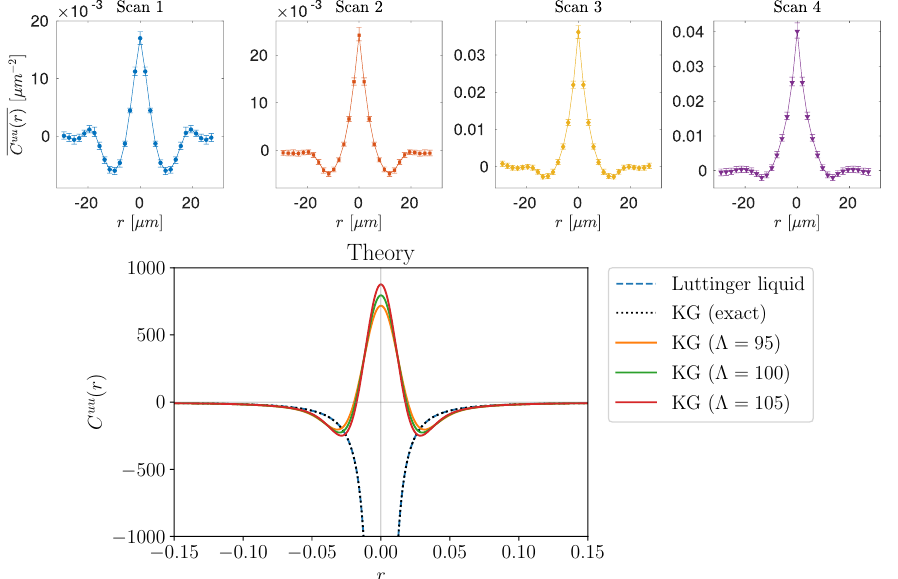
Figure 6: Top : Longitudinally averaged velocity field correlations C uu ( r ) for state preparations used in Ref. [ 24 ] . From left to right the tunneling strength is reduced. For all scans we see an auto-correlation peak for r ≈ 0. We see that in the KG regime